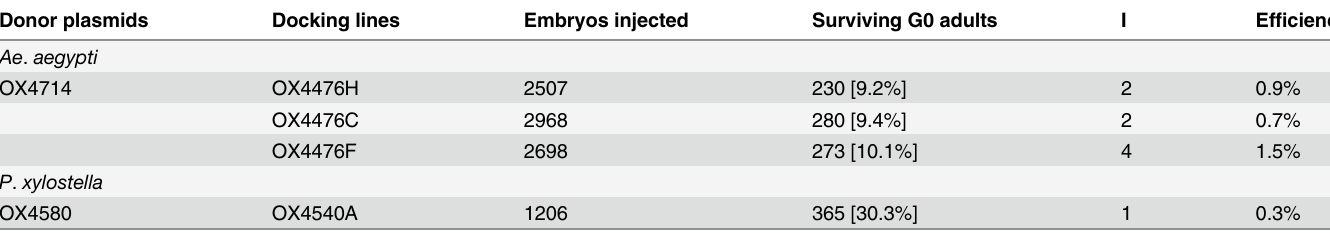
Table 3. Summary of Ae . aegypti and P . xylostella injections for Φ C31- att integration. Donor